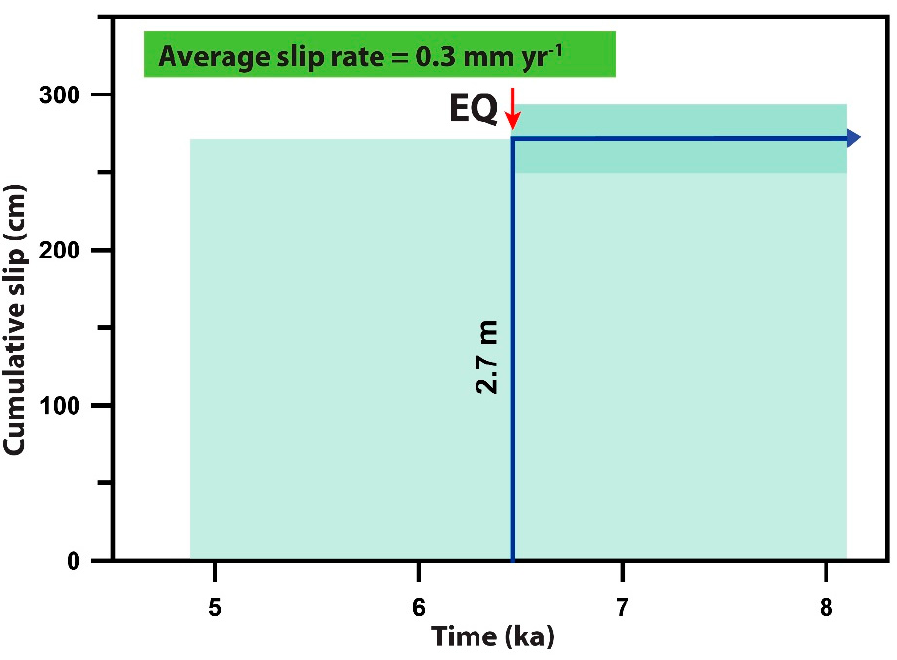
Figure 10. Cumulative slip versus time. Green bands show the uncertainties of seismic events ages and colluvium level obtained from modeling of Mug ı rtepe fault; the average slip rate is 0.3 mm yr − 1 .